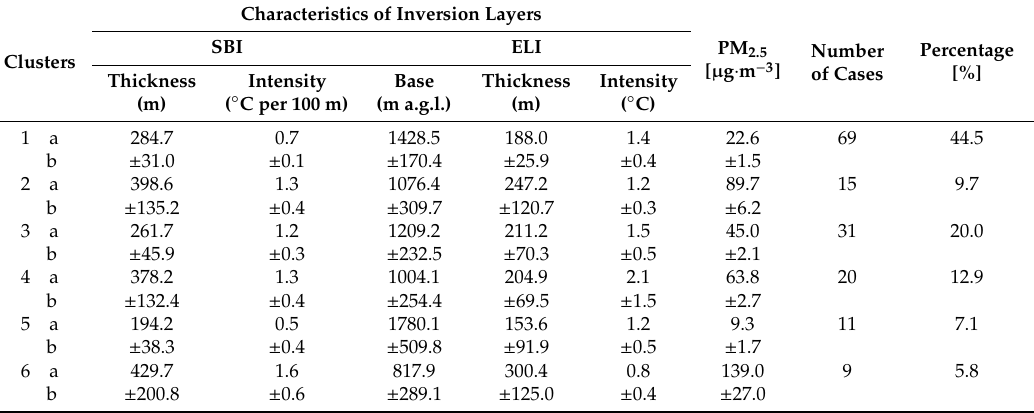
Table 2. Characteristics of inversion layers and PM 2.5 concentrations in distinct clusters.